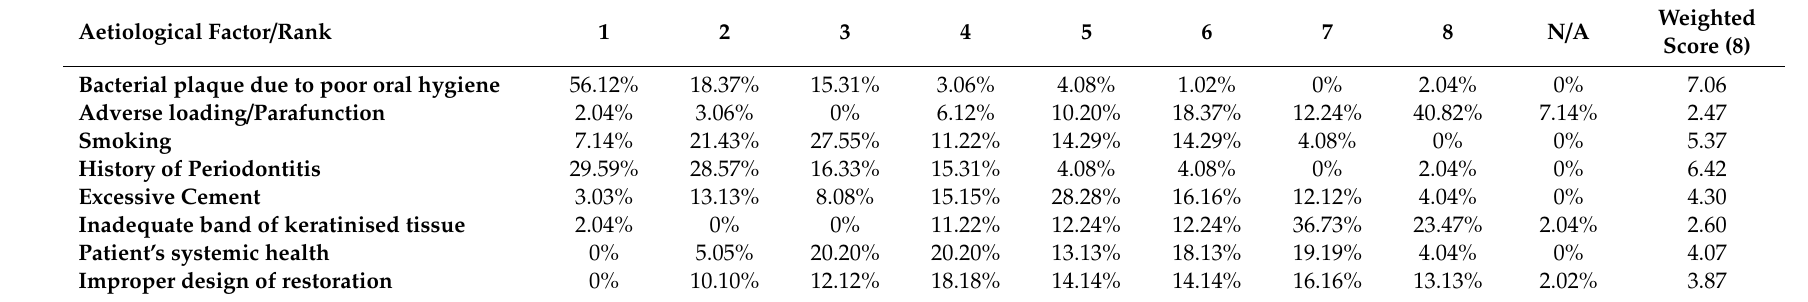
Table 2. Aetiological Factor Ranking: weighted score out of 8 (higher = more commonly